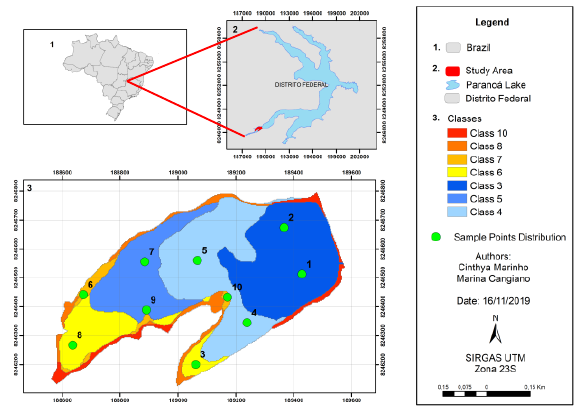
Figura 1 : Classification and Sampling Delimitation Map